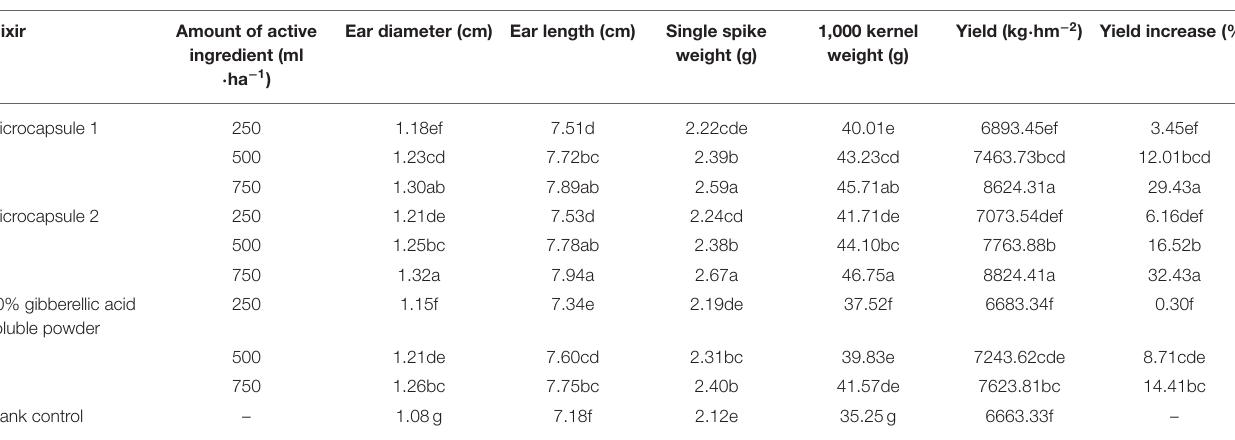
TABLE 3 | An effect of the different pesticides on wheat